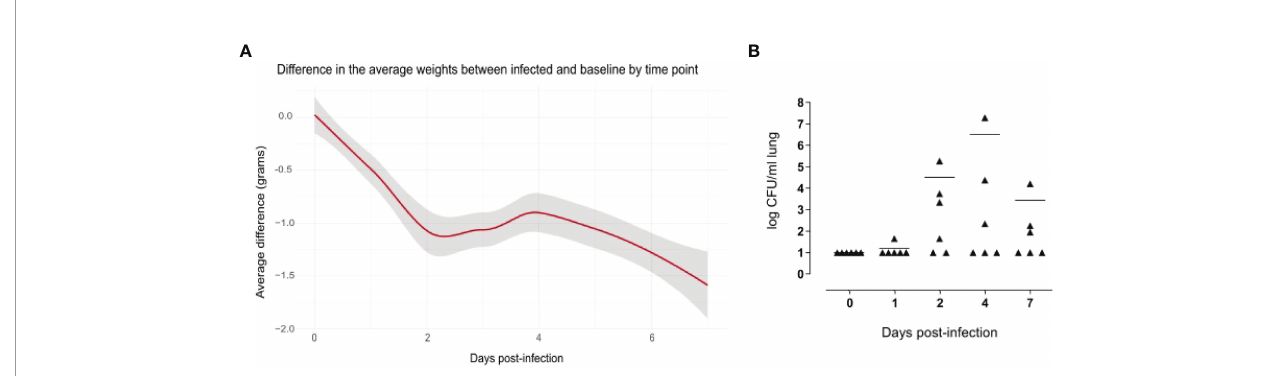
FIGURE 2 | Evidence of pneumococcal lung infection. Comparison of body weight variation of infected versus baseline (A) . Infected (n=36) and uninfected (n=5) mice were weighed every 24 hours for a period of 7 days. Values were obtained subtracting the pre-inoculum body weight from the body weight at each time-point, and then subtracting the mean in the control group from mean of the infected group in each time point. The average differences are expressed in grams and the gray shade represents the 0.95 con fi dence interval. From days 2 to 7 there were signi fi cant differences between the infected and baseline groups (p < 0.05, calculated using Mann-Whitney test. Pneumococcal cell counts in the lungs (B) . The lungs of mice sacri fi ced at 1, 2, 4 and 7 days after infection (n=6 per group) were collected, homogenized in a fi nal volume of 1 ml and plated using a multilayer plating procedure. Pneumococcal cells were counted after 24 hours and 48 hours of incubation. Lungs of uninfected mice (0 days post-infection) were plated as a negative control. Data are expressed as CFUs/ml lung. The lower limit of detection was 10 CFU/ml lung. Average cell counts had a peak at day 4. For each time point, there were at least 2 mice without detectable